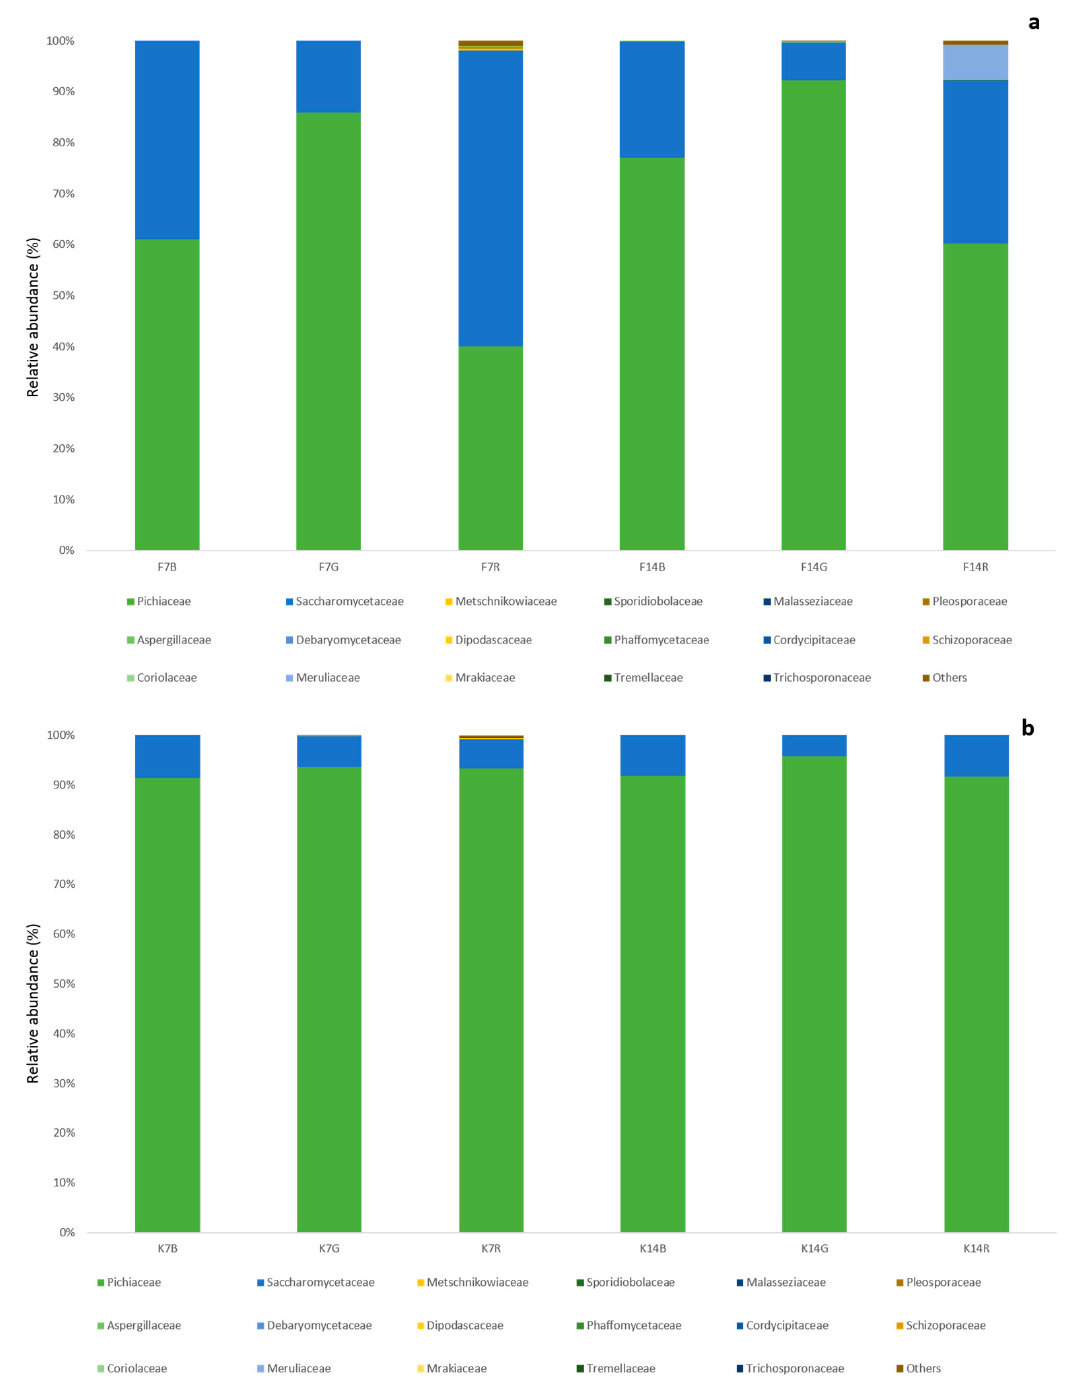
Figure 3. The influence of substrate and matrix on bacterial community structure of kombucha (family level) after 7 ( a ) and 14 ( b ) days of fermentation, as determined by internal transcribed spacer two (ITS2) gene amplicon sequencing.